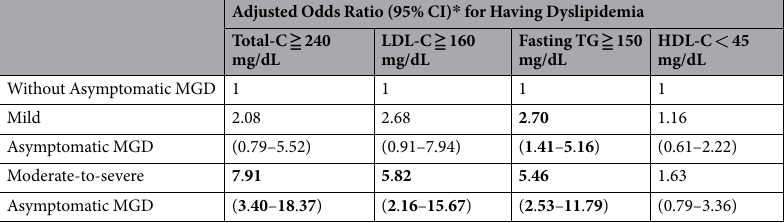
Table 4. Associations between the Severity of Asymptomatic Meibomian Gland Dysfunction and Risk of Having Dyslipidemia. CI = Confidence Interval; Fasting TG = fasting triglyceride; HDL-C = high-density lipoprotein cholesterol; LDL-C = low-density lipoprotein cholesterol; MGD = meibomian gland dysfunction; Total-C = total cholesterol. * Adjusted for age and gender. Correlations significant at P < 0.05 are